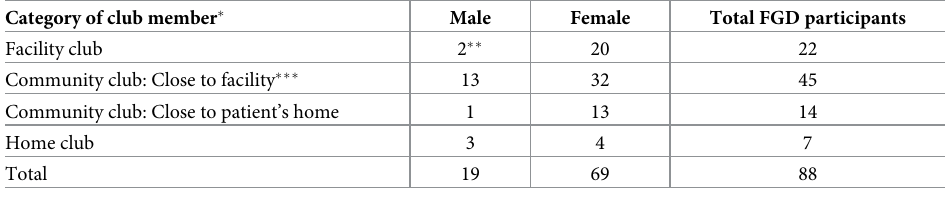
Table 1. Categories of club members participating in focus group discussions